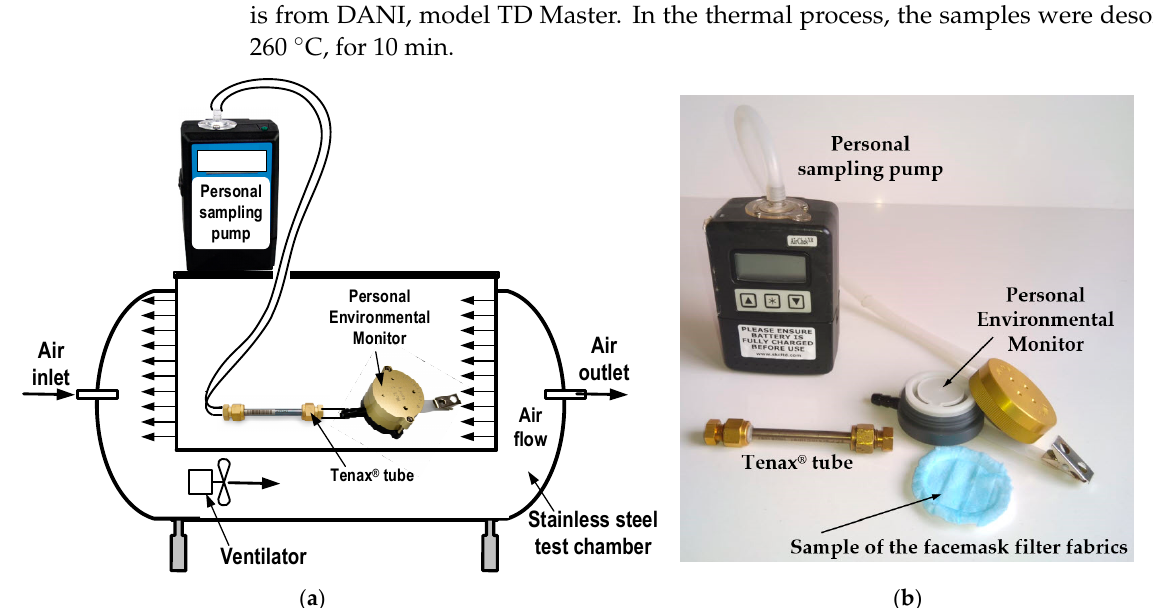
Figure 2. ( a ) Experimental setup and ( b ) equipment and materials used in the experimental setup required to measure VOCs emitted by the facemask materials (figure and photo credits to the